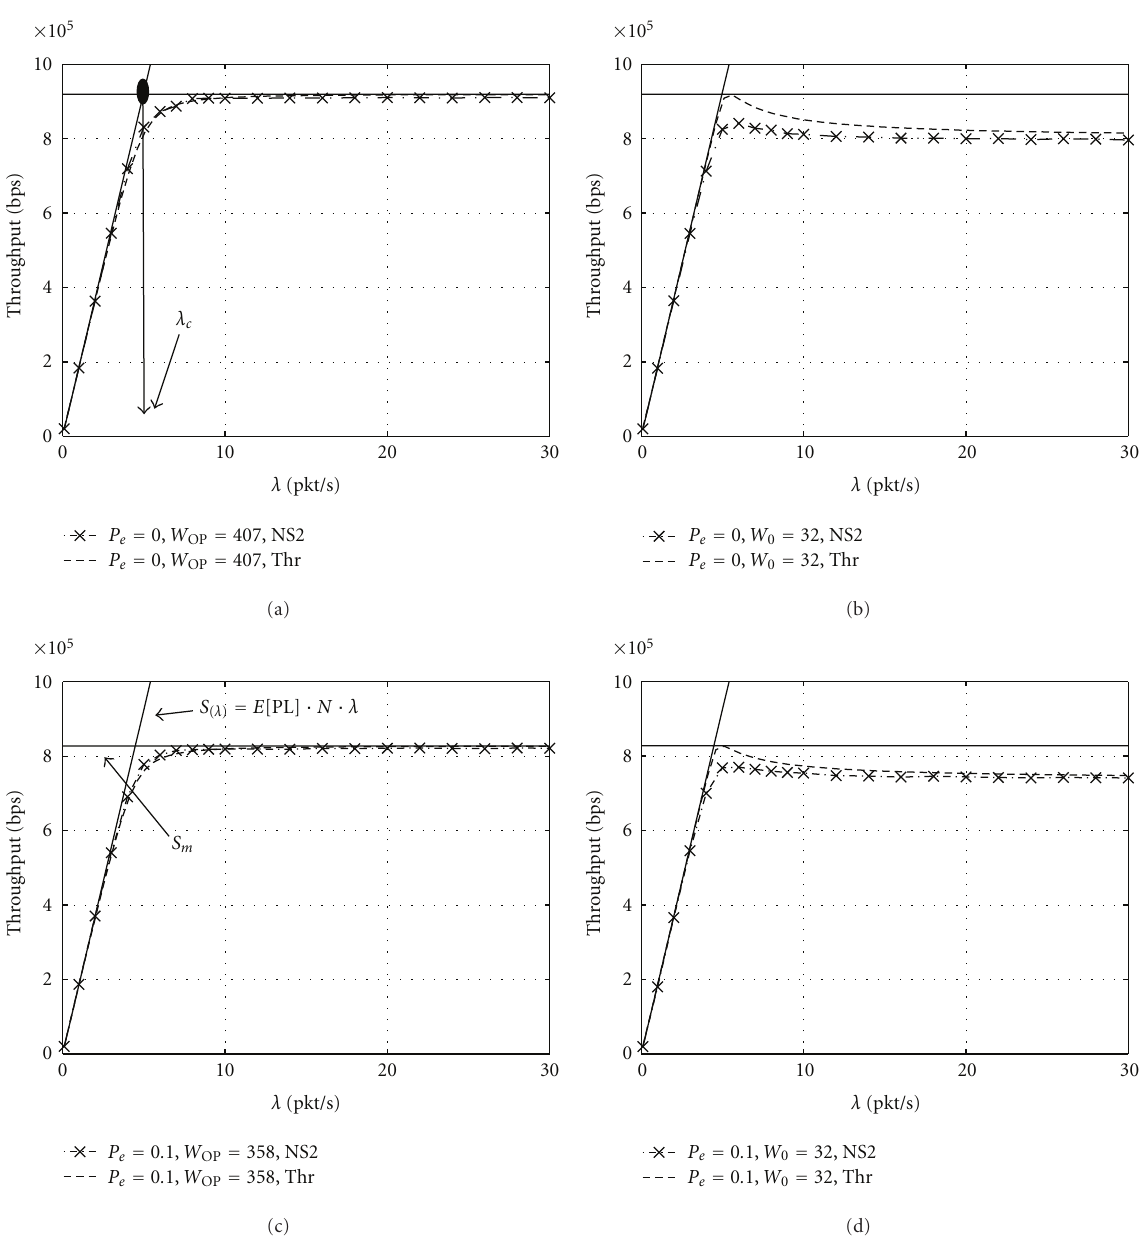
Figure 2: Throughput for the 2-way mechanism as a function of the packet rate λ , for N = 10, m = 5, packet size E [PL] = 2312 bytes, and di ff erent values of P e and W 0 as noticed in the respective legends. Continuous straight lines refer to the linear model of the throughput S ( λ ) = N · E [PL] · λ derived in (9), while the horizontal line corresponds to S m noticed in (13). Dashed lines, labeled Thr, refer to the theoretical throughput in (7), while dash-dotted lines labeled NS2 identify the simulation results obtained with ns-2.